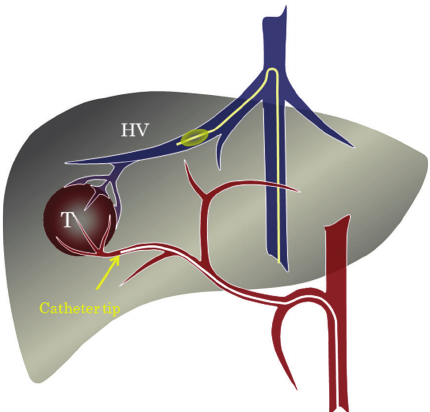
Figure 1: Schema of TACE under hepatic vein occlusion for HCC with significant arteriovenous shunts. T: tumor; HV: hepatic